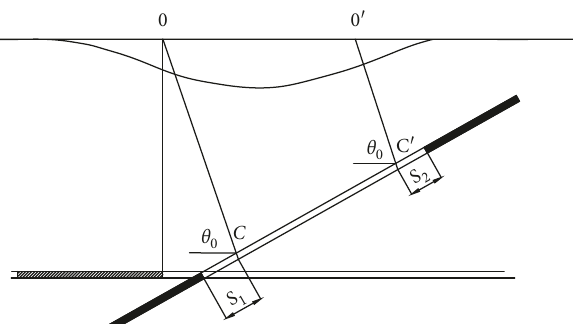
Figure 12: Theory of statistic model.